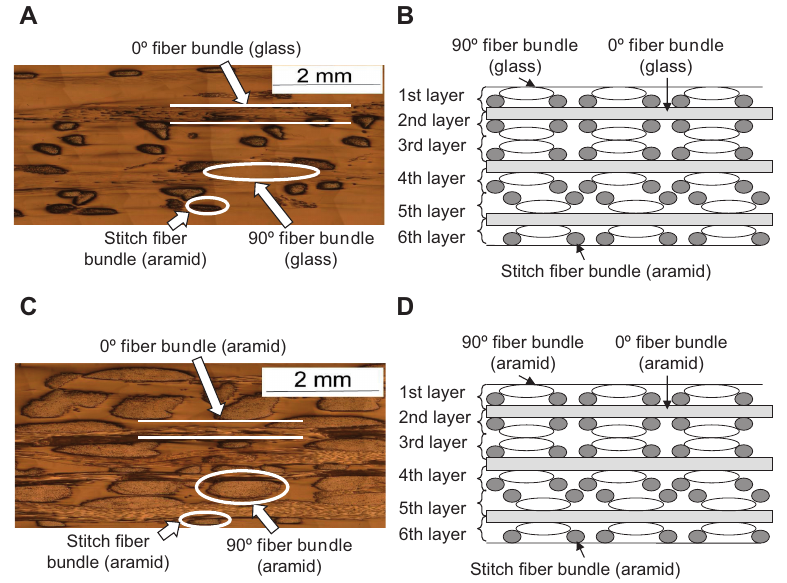
Figure 3 Cross-sectional photographs of as-fabricated composites and schematic drawings: (A, B) GF-GF-AR and (C, D) AR-AR-AR.